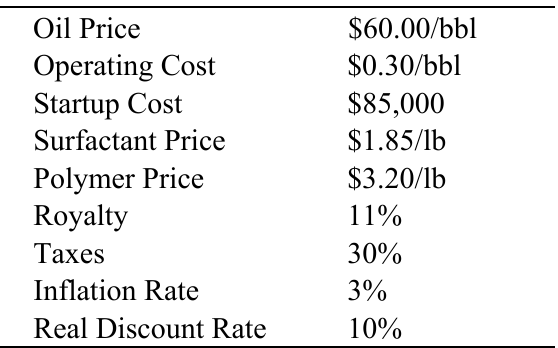
Table 2. Economic assumptions used in this study.